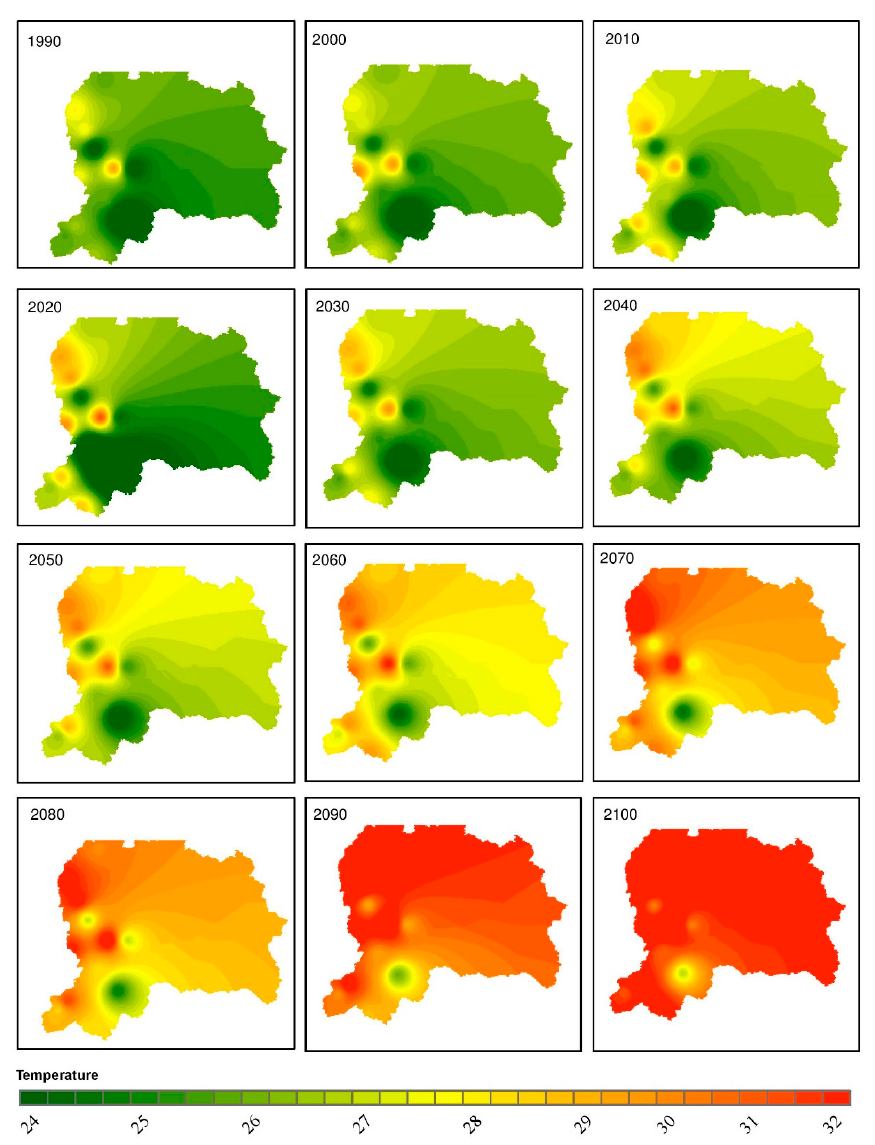
Figure 7. The projected change in average temperature (°C) from 1990 to 2100. Figure 7 revealed the average temperature from 1990 to 2100 within the transboundary Mangla Watershed. The best adopted downscaling technique for the watershed, i.e., distribution mapping downscaling, was used to predict these results. Figure 7 represents that the maximum rise in temperature till 2100 will be 8.9 °C. It is a large increase in temperature which will definitely increase evapotranspiration and also cause glaciers to melt and will severely affect freshwater resources in the future. Figure 8 shows the projected change in precipitation (mm) over the Mangla watershed from the year 1990 to 2100. In 1990, there was less precipitation in most of the watershed, and it increases continuously in the future from 2021 to 2100. The northern part of the Mangla Watershed located at